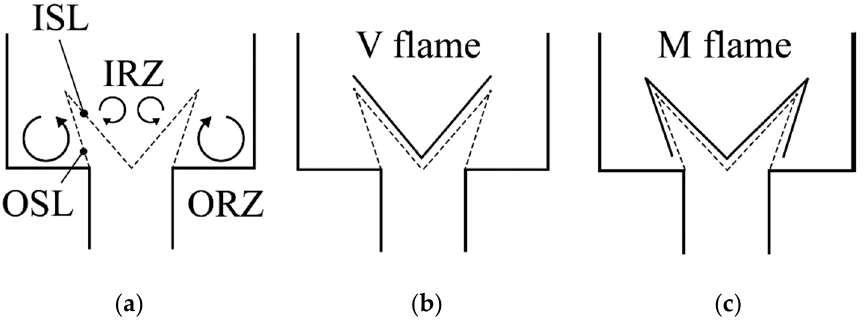
Figure 9. Scheme of swirling flow in the combustion chamber [21]: ( a ) graphical description of the inner and outer recirculation zones and internal shear layer; ( b ) V-shape flame; ( c ) M-shape flame.